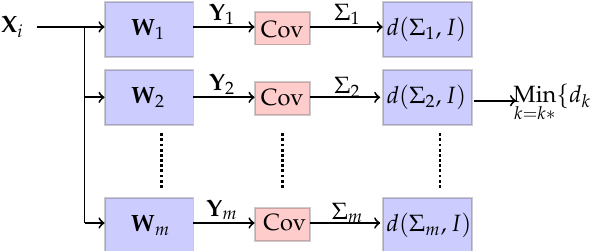
Figure 2. Radiometric identification by whitening transformations. The branch with the most whitened data reveals the source of the unknown